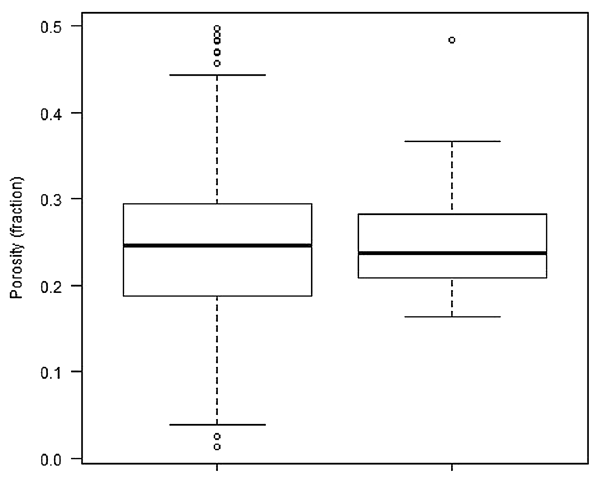
Fig. 8 Box plots of individual porosity values (left) and well-mean porosity values